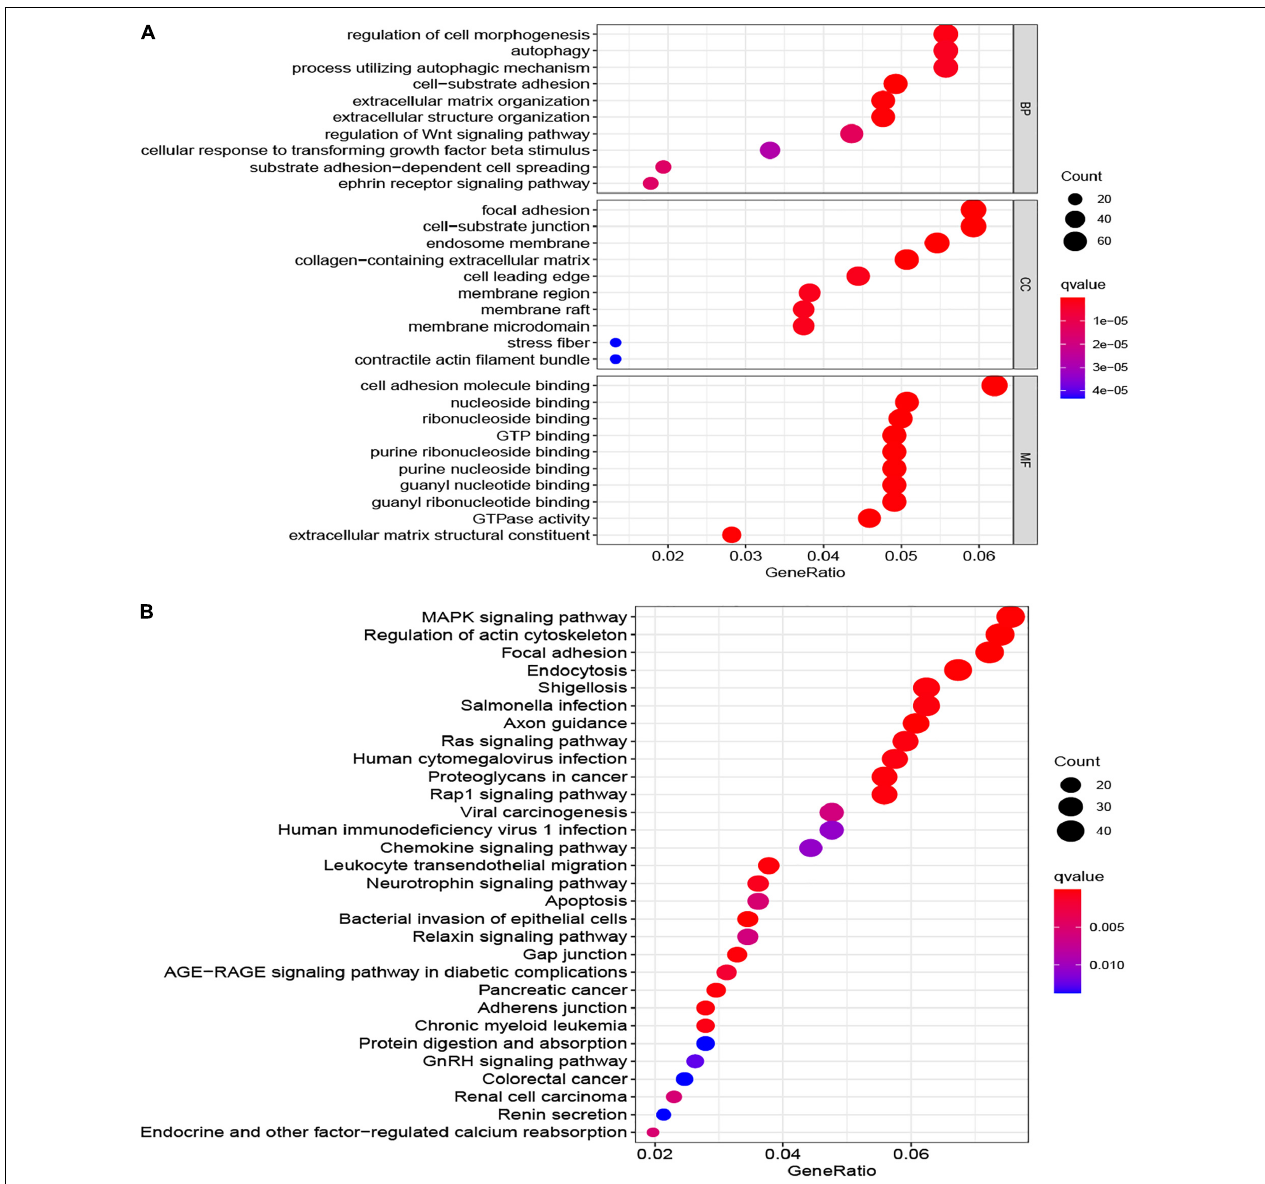
FIGURE 9 | The most significant outcomes of GO (A) and KEGG (B) analysis of DEGs between high- and low-risk